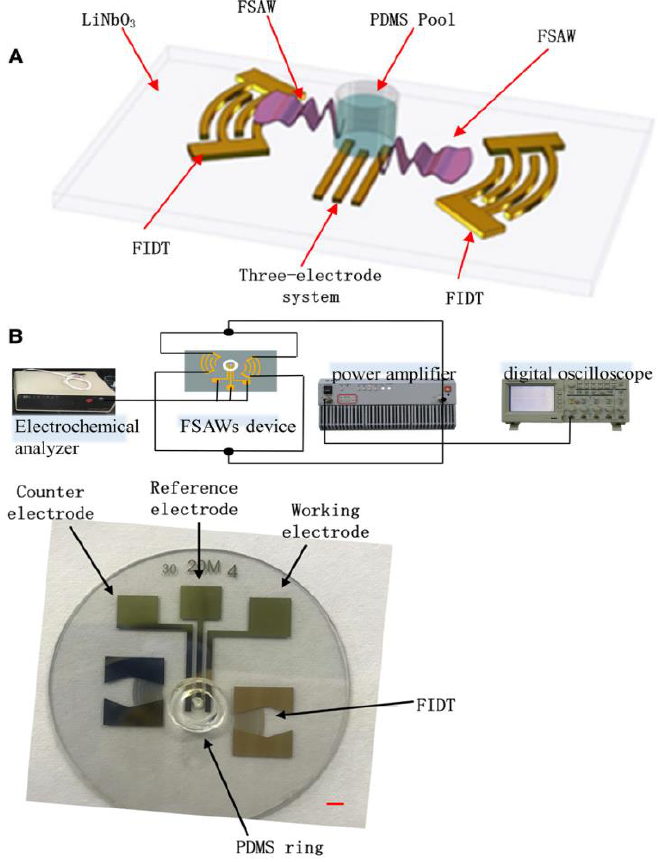
Figure 23. A generic approach for SAW devices with microfluidics [185].